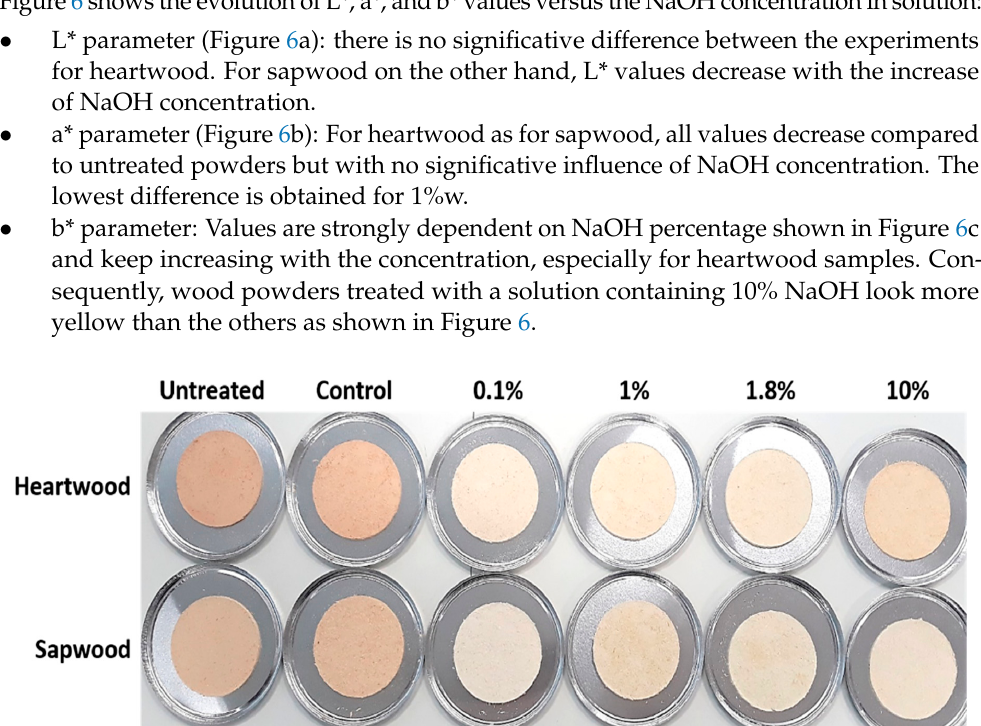
Figure 5. Impact of NaOH concentration variation on maritime pine wood color.